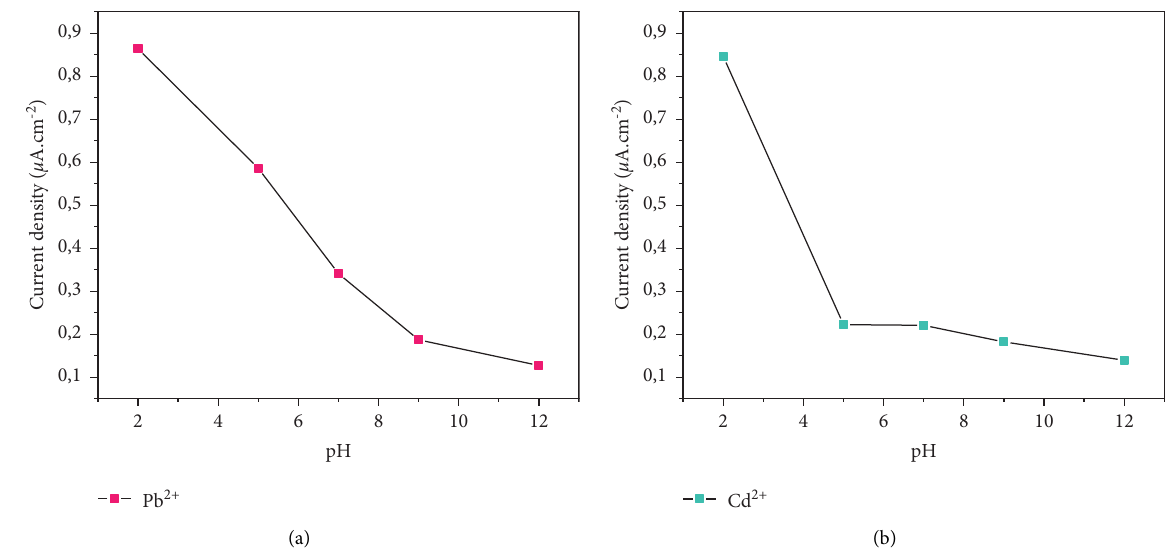
Figure 8: Effect of pH by SWV (Hg/Hg